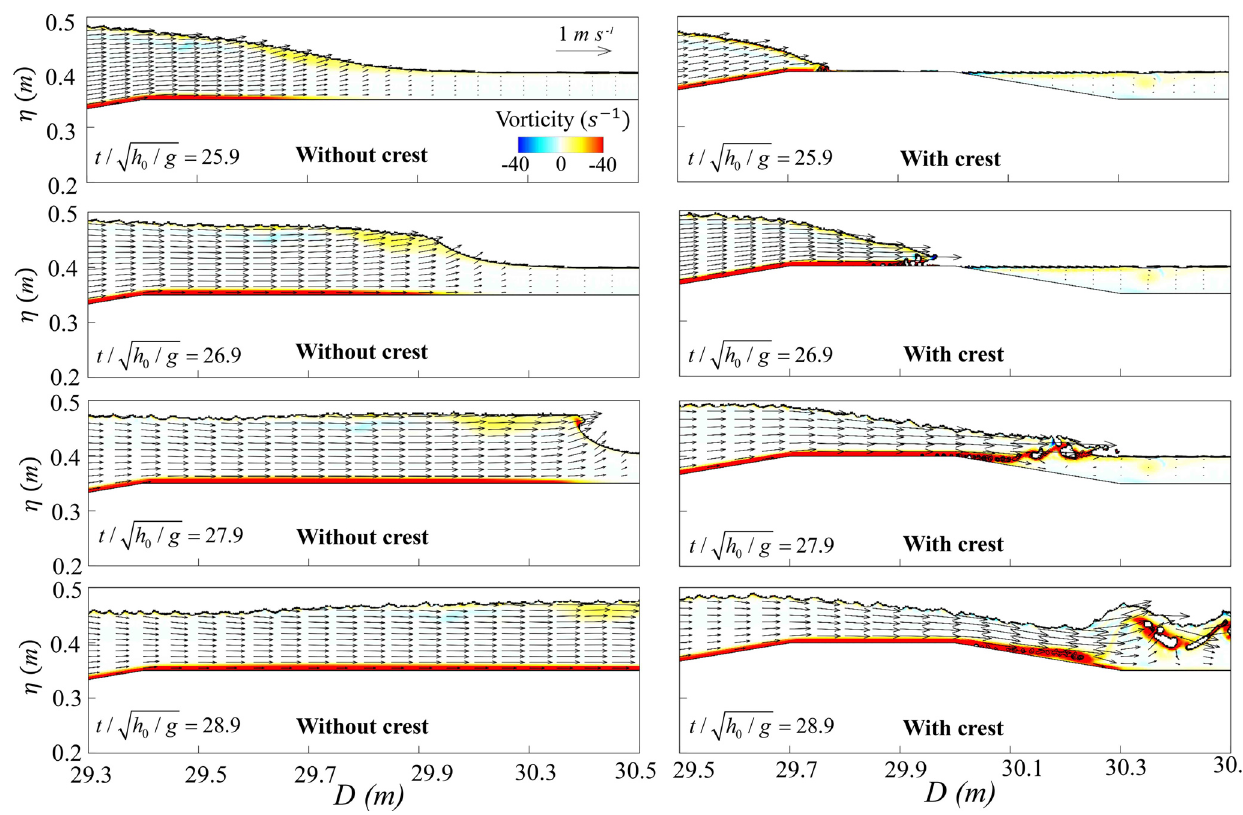
√ h 0 /g ) between the reefs with and